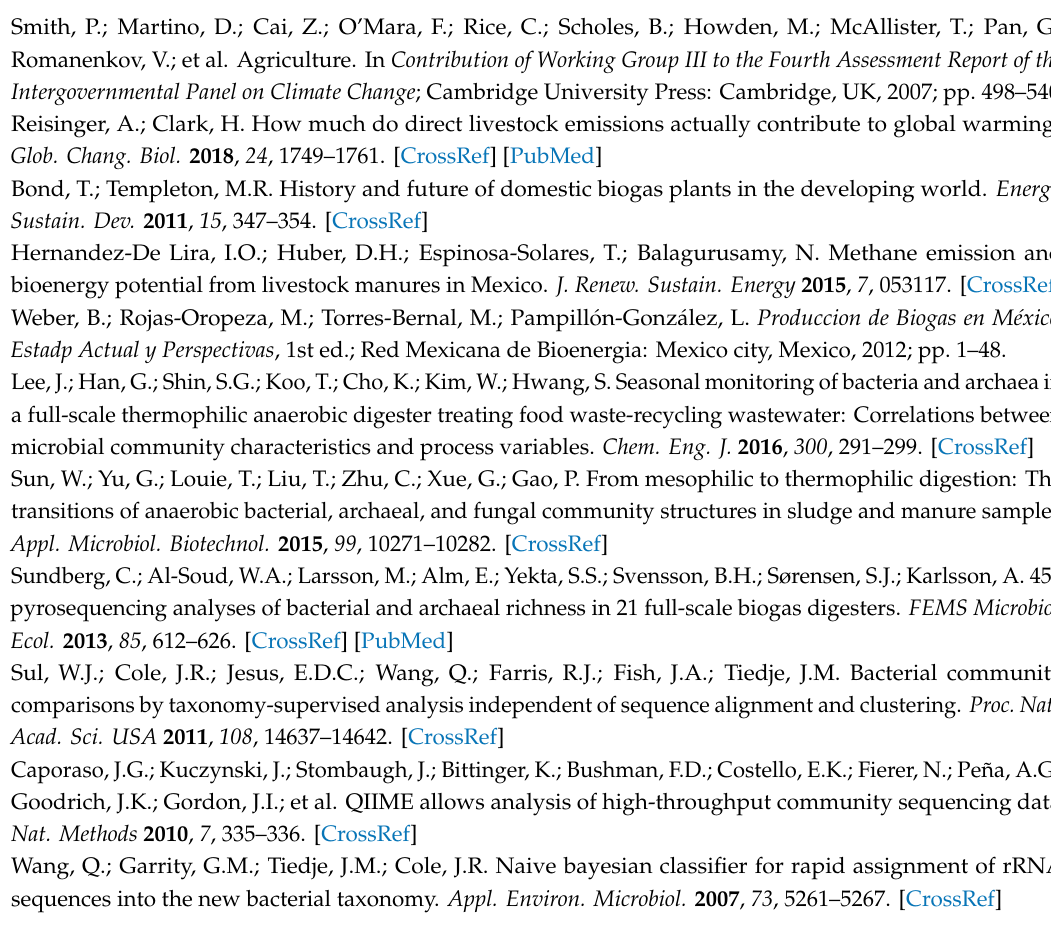
Figure S1: Comparison of diversity between the di ff erent sampling points of the biodigester using di ff erent measures of alpha diversity, (a) Observed OTUs, (b) Chao1 index, (c) Shannon index and (d) Simpson index; Figure S2: Rarefaction curves for 16 S rRNA gene sequences derived from the biodigester (OTUs are retrieved at 97% of similarity); Figure S3: Prediction of functional profiling by abundances of KEGG pathways in level-3 (Amino acid metabolism) by using PICRUSt; Figure S4: Prediction of functional profiling by abundances of KEGG pathways in level-3 (Carbohydrate metabolism) by using PICRUSt; Figure S5: Abundances of KEGG pathways in level-2 of the functional prediction by